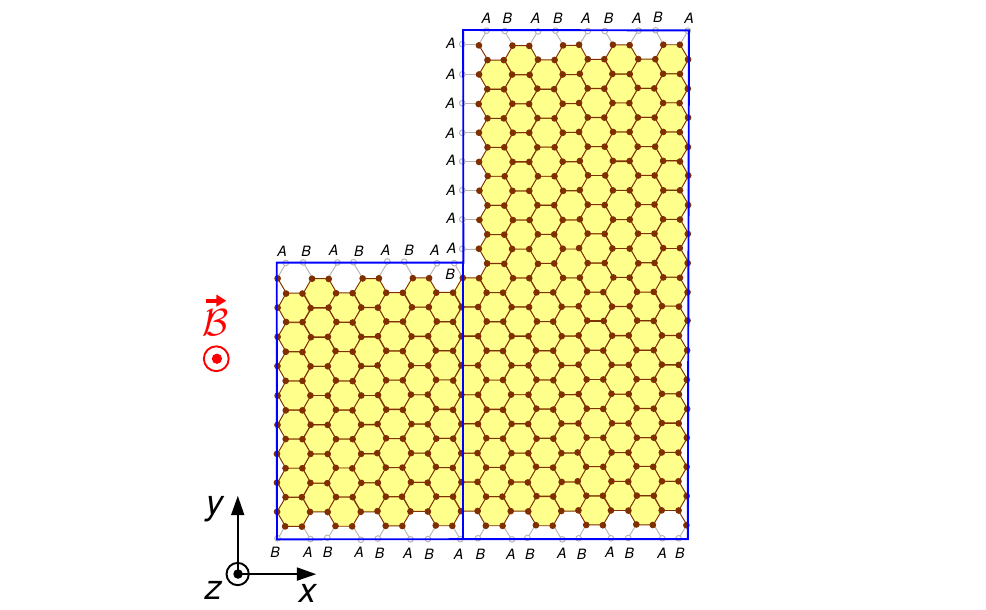
Figure 2. Case with two adjacent slices with edges not aligned; in this case, α = A (as defined in the